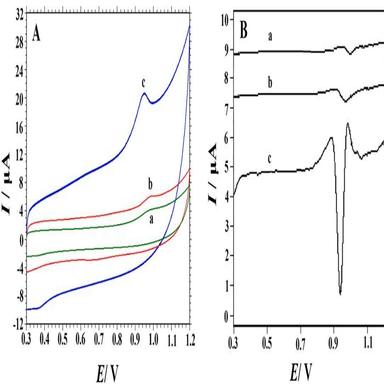
(A) CVs and (B) SDLSVs obtained at (a) bare CPE, (b) N-C/CPE and (c) Ni NPs/N-C/CPE in 0.02 M H3PO4 solution containing 50 μM Trp. Scan rate: 0.1 V s − 1 .